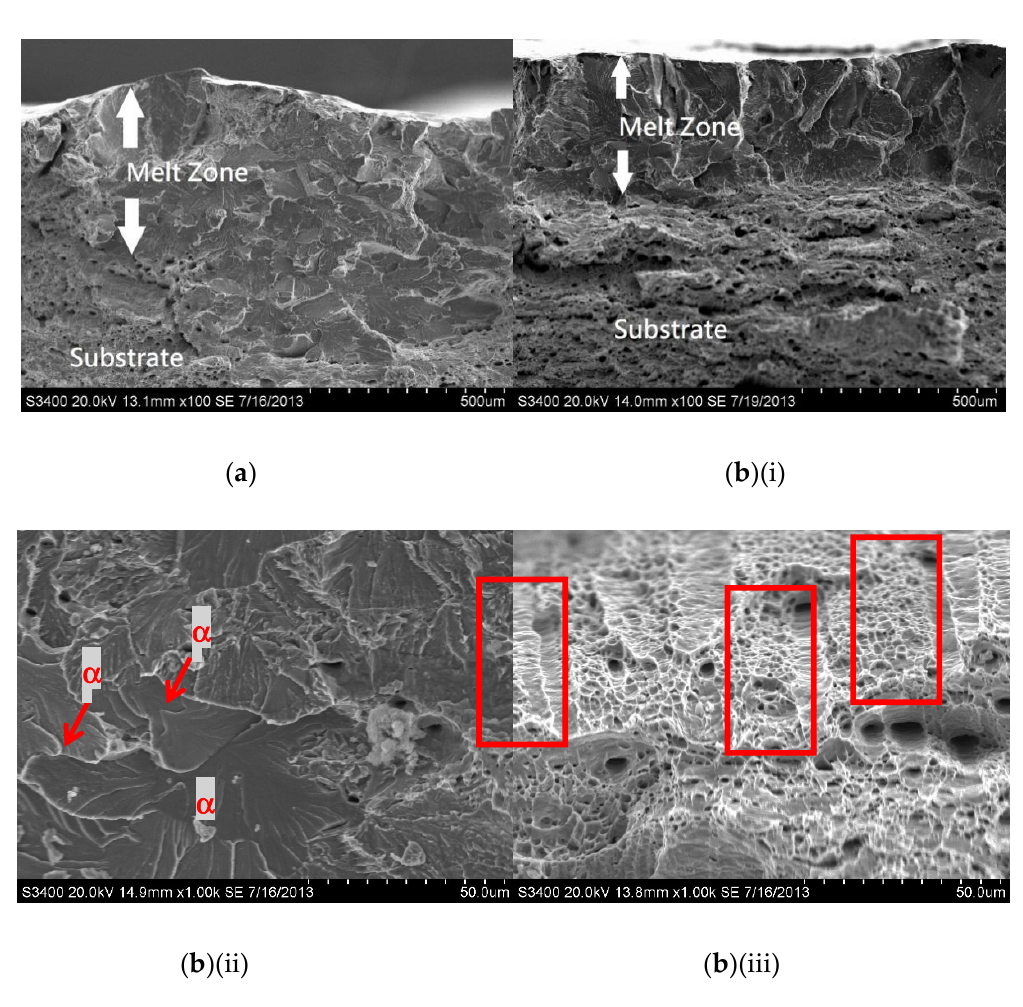
Figure 7. SEM fractographs of laser-surface melted AISI 430 steel (V60) ( a ) without hydrogen pre-charging; ( b )(i) with hydrogen pre-charging, ( b )(ii) MZ of (b)(i), and (iii) substrate of ( b )(i).